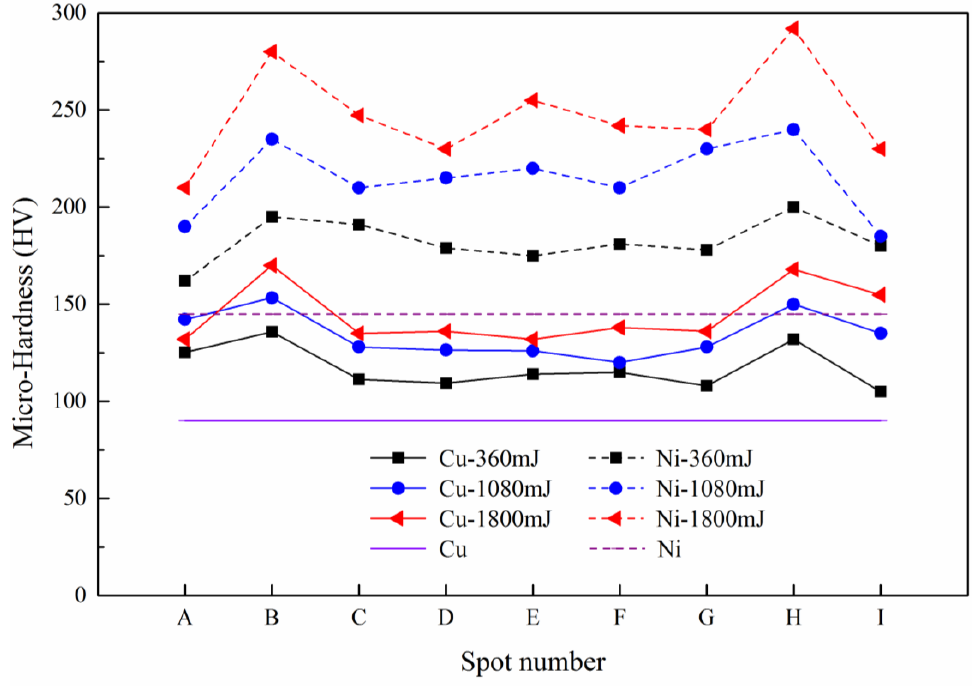
Figure 20. The micro-hardness distribution at room temperature.